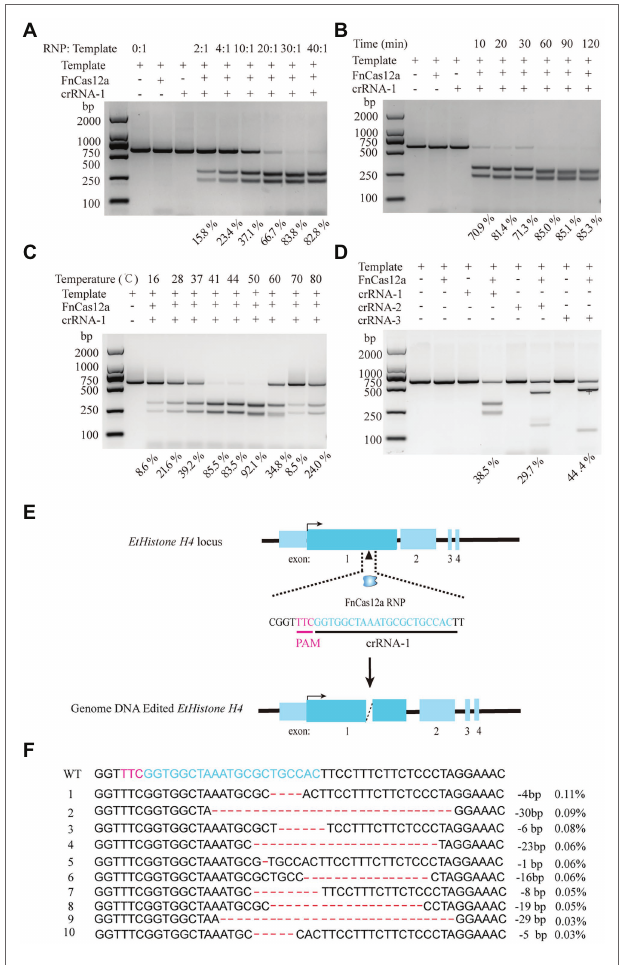
FIGURE 2 | FnCas12a-mediated gene knock-out in E. tenella . (A) The effect of the molar ratio of RNP/template on in vitro cleavage efficiency of the EtHistone H4 fragment. The molar ratio of RNP/template at 0:1, 2:1, 4:1, 10:1, 20:1, 30:1, 40:1, respectively, with the temperature at 37 ° C and reaction time of 60 min. (B) The effects of incubation times. The reaction time of 10, 20, 30, 60, 90, and 120 min with the temperature at 37 ° C and the molar ratio of RNP/ template at 30:1. (C) The effects of reaction temperature for the cleavage. The reaction at the temperature of 16, 28, 37, 41, 44, 50, 60, 70, and 80 ° C, respectively, with the molar ratio of RNP/template was 30:1 and reaction time of 10 min. (D) Comparison of cleavage activity of three crRNAs. The molar ratio of RNP/template at 10:1, incubated in 37 ° C for 60 min. The edited products were quantified with agarose gel electrophoresis. (E) Schematic diagram of FnCas12a/crRNA-1 trigger genome editing in EtHistone H4 . (F) The top 10 indels were obtained via next-generation